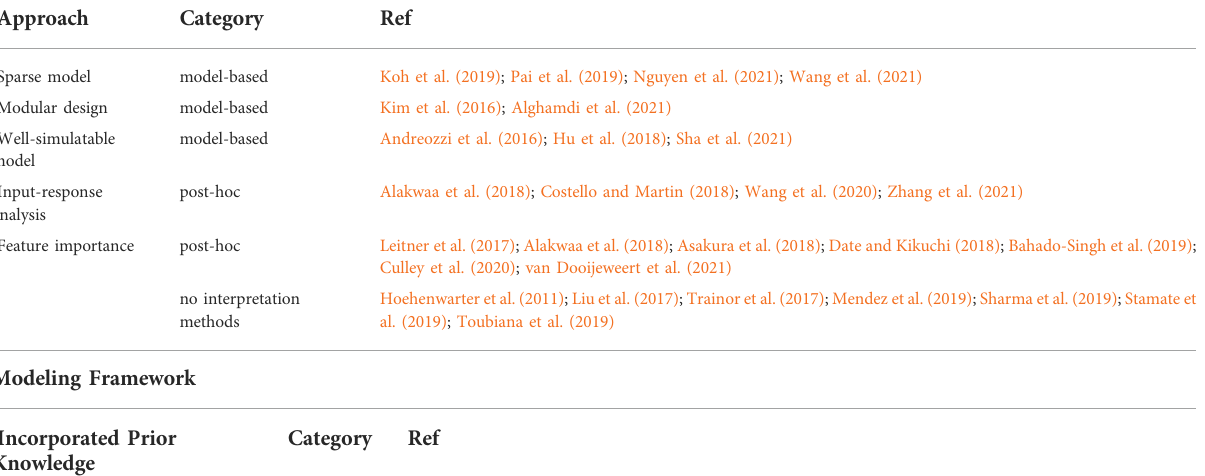
TABLE 2 Categorization of research studies applying machine learning techniques to non-sequential omics data sets. Summary of interpretation methods, assigned category and the approach demonstrated in the publication that led to this classi fi cation ( top ). Summary of utilized modeling frameworks, assigned category and prior knowledge that entered the modeling framework ( bottom